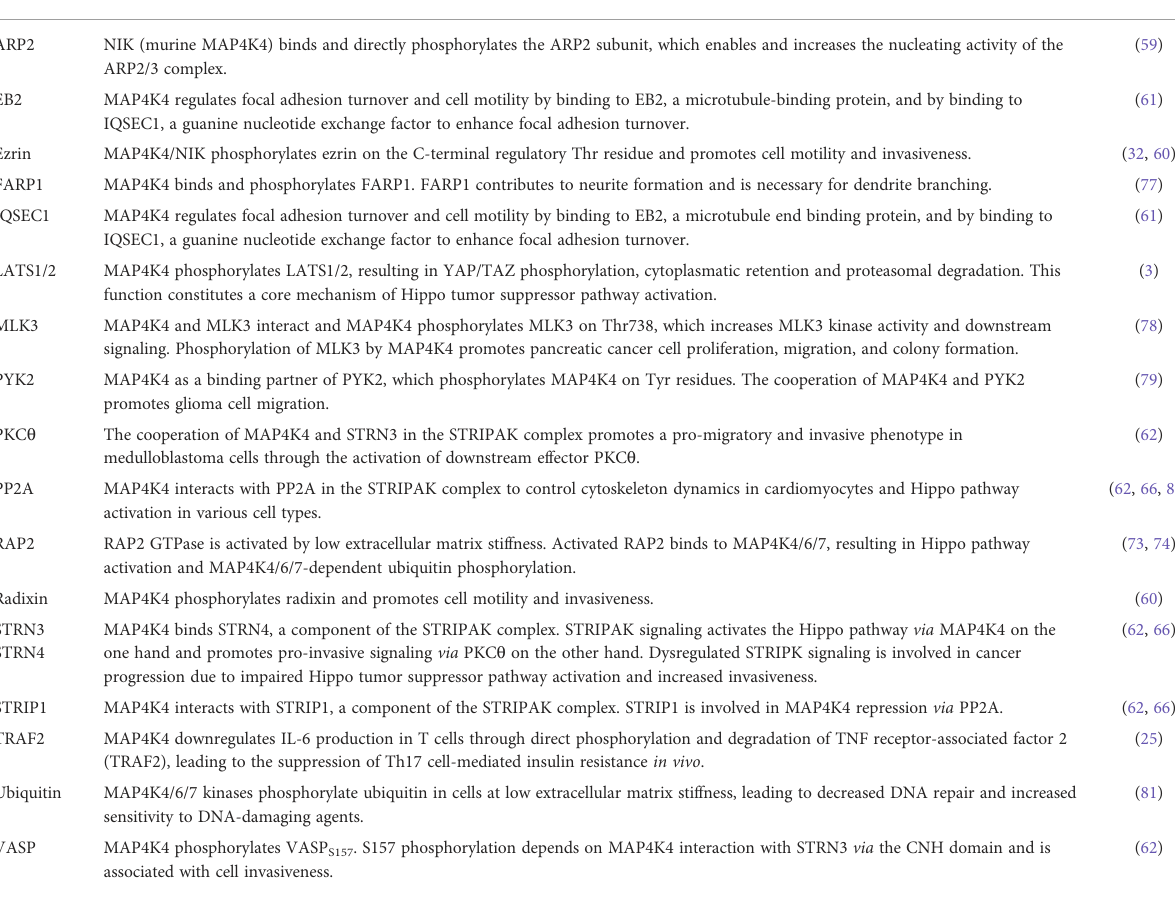
TABLE 2 Summary of interactors and substrates of MAP4K4. Interactor Function